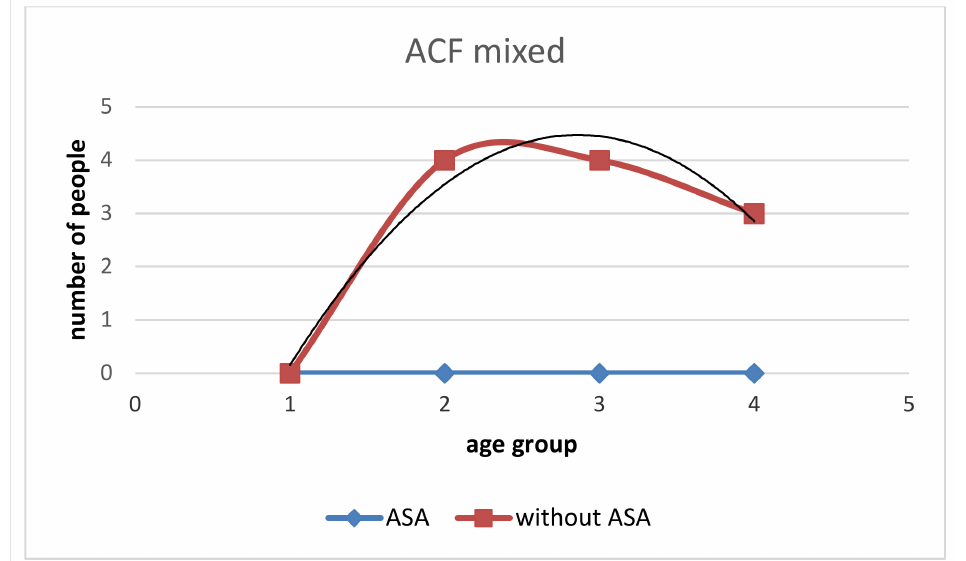
Figure 5. Incidence of ACF mixed in the group with ASA and without ASA. No ACF mixed was observed in subjects with ASA. In those without ASA, the increase in the number of ACF mixed decreases with age. After age 50, the number of this type of ACF is similar in all age groups in those without ASA.